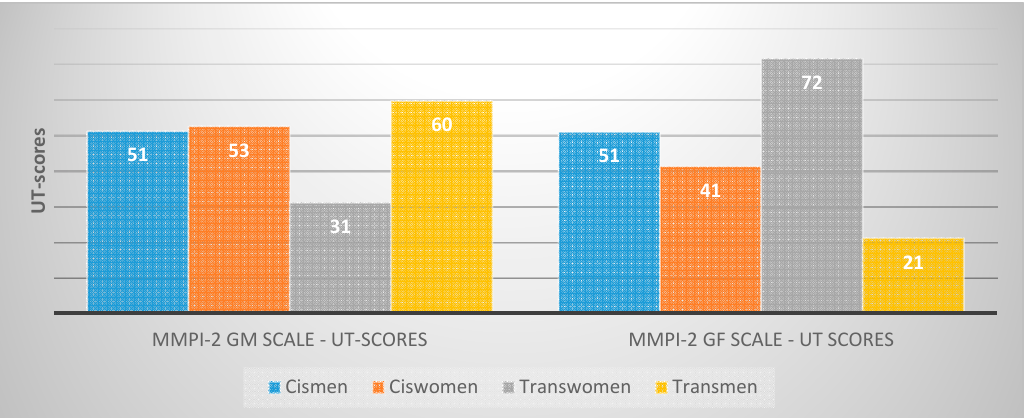
Figure 1. UT scores on Gender Role—Masculine (GM) and Gender Role—Feminine (GF) MMPI ‐ 2 (Minnesota Multiphasic Personality Inventory, 2 nd version) scales for the cis ‐ and transgender participants (according to Russian population norms).